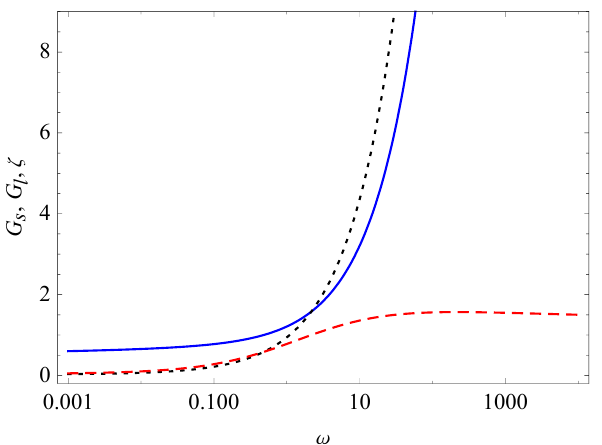
Figure 11. Curves of G s (solid line), G l (dotted line), and ζ (dashed line) versus ω for a = 1, b 0 = 0.5, b 1 = 1, b 2 = 2, α = 0.2, and β = 0.8 in the fractional six-parameter model